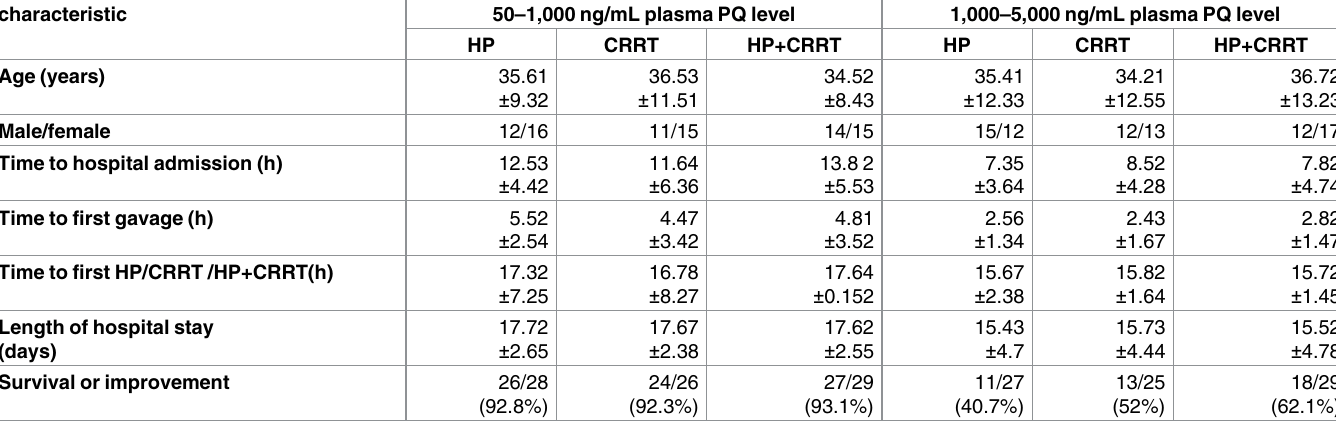
Table 1. Clinical characteristics of paraquat (PQ)-poisoned patients (n = 164). characteristic